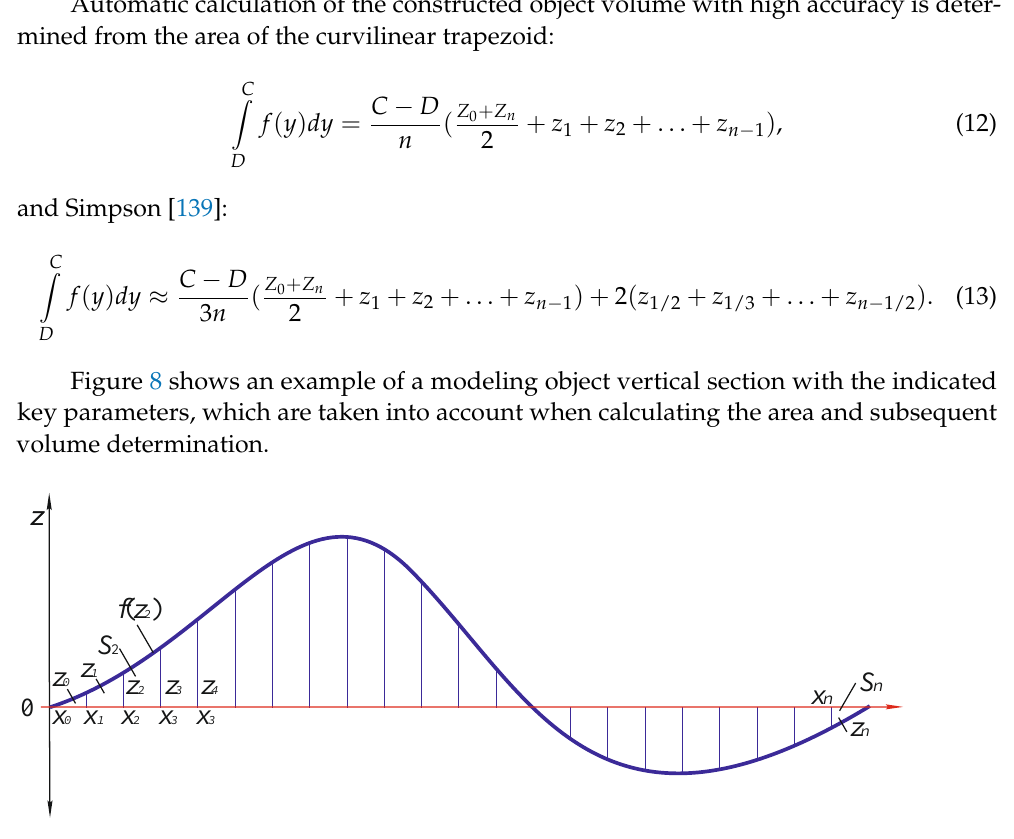
Figure 8. Scheme for determining the area of the modeling object vertical section. The range of the approximating surface is to determine the boundaries of the maxi- mum and minimum coordinates of observation points, which are grouped and divided into lines j and columns i. The reliability of the determined volume depends on the value of space between the lines and columns. The above algorithm, described on the basis of the Surfer-8.0 software, is used for the computer-based determination of the dissociation volume in the tank of a laboratory setup. This program, which is based on the data interpolation method, makes it possible to describe the boundaries of three-dimensional bodies by determining their volume with high accuracy. The method of determining intermediate values and quantities from the available discrete set of known values is a very effective way to solve such problems. This interpolation method of geostatics, science, and technology for the analysis, processing, and presentation of spatially-distributed information is based on the gener- alized linear “Kriging” regression [140–142]. This kind of regression uses parameters to determine the optimal estimates in terms of the minimum root-mean-square deviations when constructing a 3D grid-visualization. The latter implies the construction of graphical data images for the possibility of their analysis and identification of anomalies with the resulting structure [134]. A significant advantage of the Surfer-8.0 software is that it is able to process three methods for calculating the volume of modeling bodies: the curvilinear trapezoid method, the Simpson method, and the Simpson’s three-eighths method [134,143]. The resulting difference in values is a qualitative comparative assessment of the volume calculation accuracy. The arithmetic mean of the three results is taken as the final volume of the